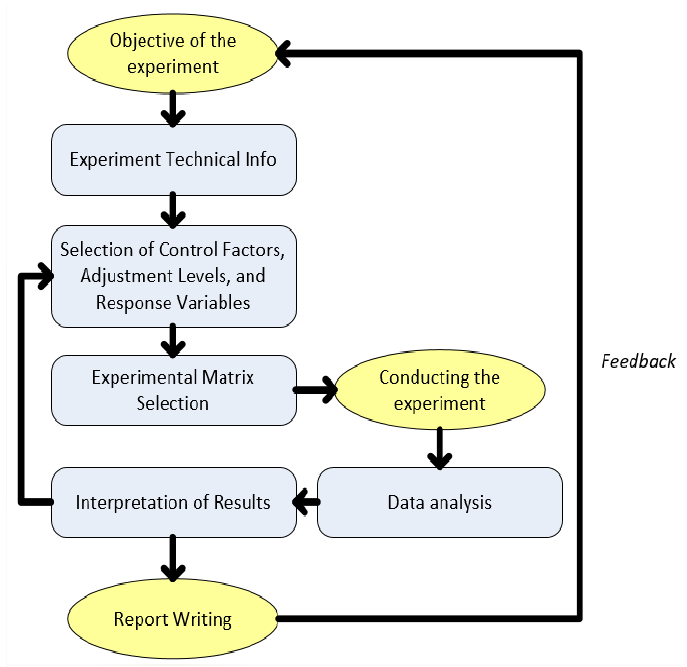
Figure 10. Protocol flowchart adopted for testing.